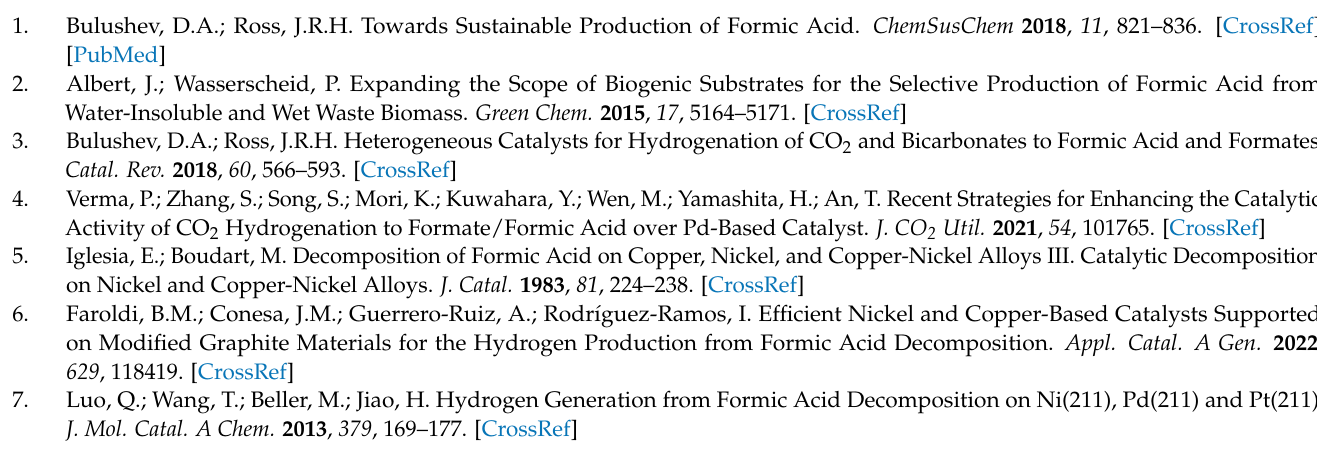
Figure S5: Comparison of experimental 1Ni/CN Ni K-edge spectrum with theoretical spectra plotted for flat and curved